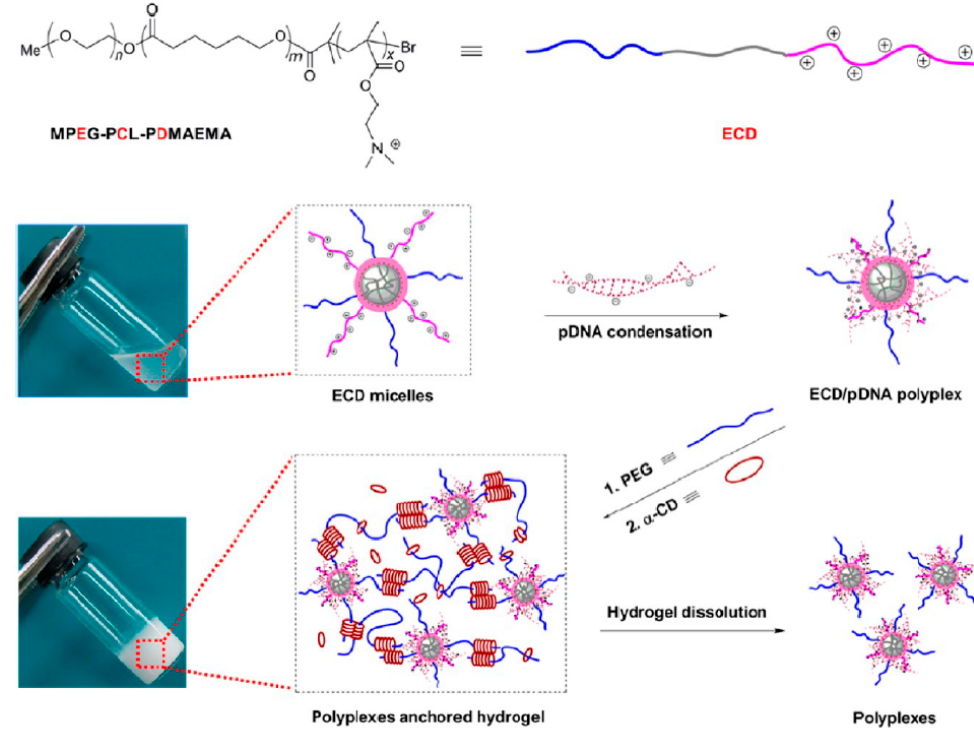
Figure 9. Schematic illustration for obtaining ECD/pDNA anchored α -CD/PEG supramolecular hydrogels (ECD corre- sponds to the MPEG-PCL-PDMAEMA, where E: MPEG, C: PCL, and D: PDMAEMA). Reprint with permission [142]; Copyright 2012, American Chemical Society.